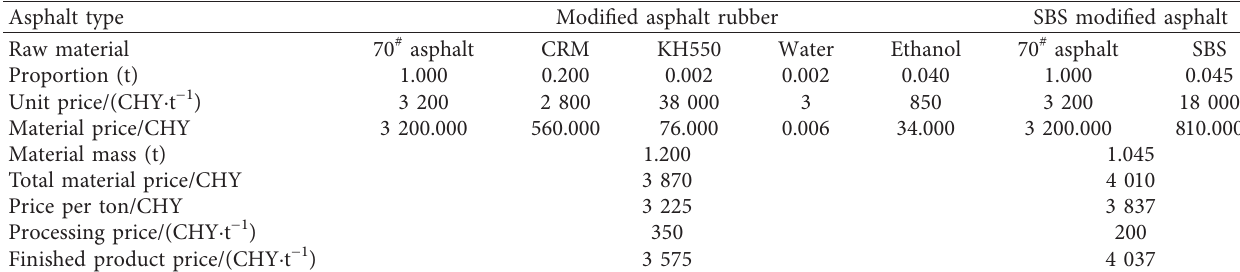
Table 9: Analysis of the economic benefit of modified asphalt